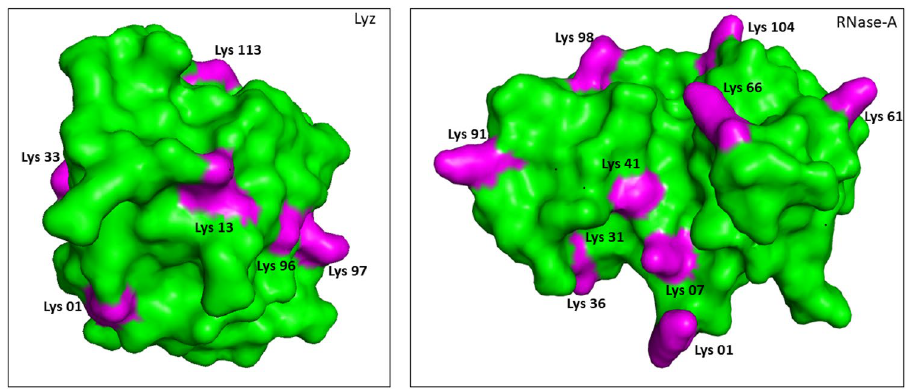
Figure 6:. 3D structures of Lyz (left panel) and RNase-A (right panel) indicating the positions of the lysine